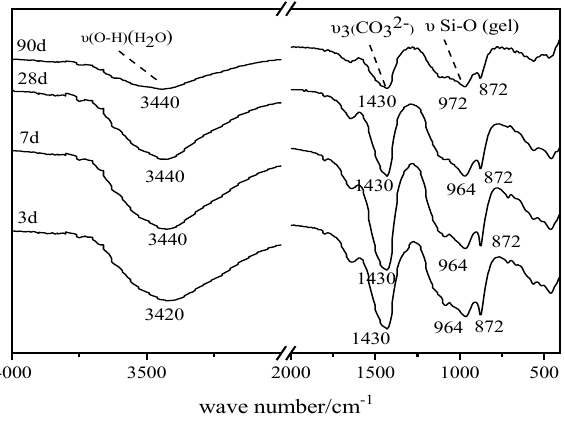
Figure 5. Fourier transform infrared spectrometer (FTIR) patterns of pastes hydrated for different ages.